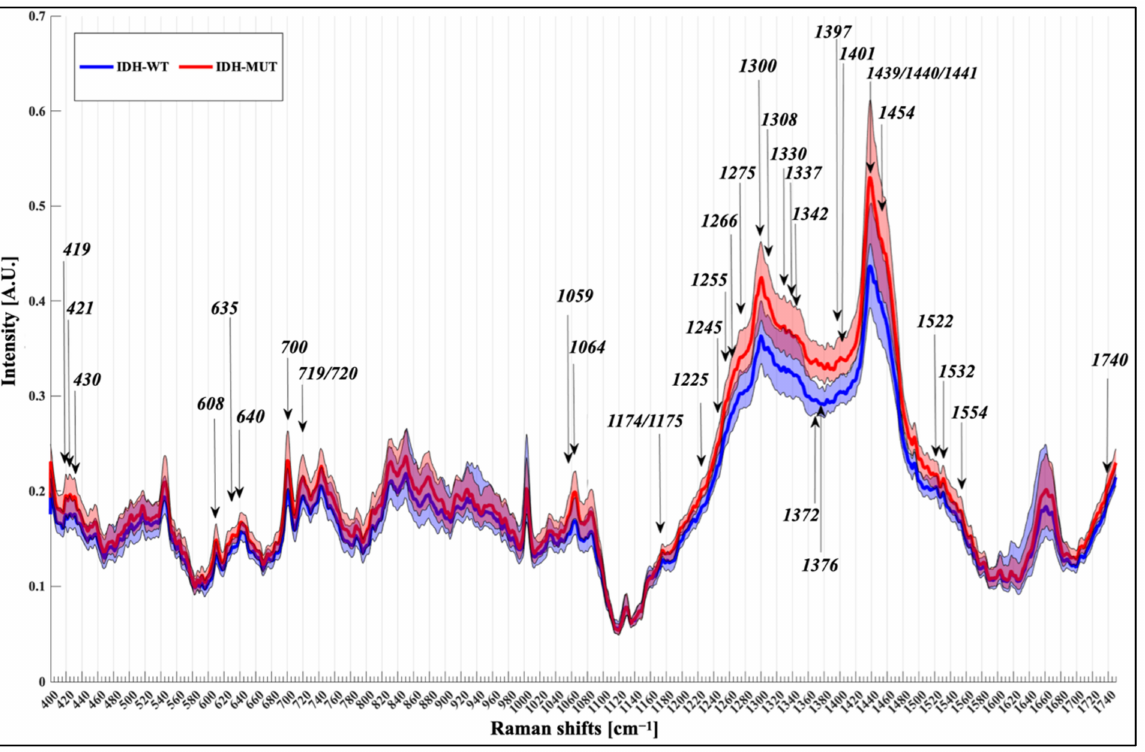
Figure 2. Normalized median spectra with IQR for IDH-WT specimens (blue) and IDH-MUT specimens (red). Arrows mark the most discriminant peaks with a known biological